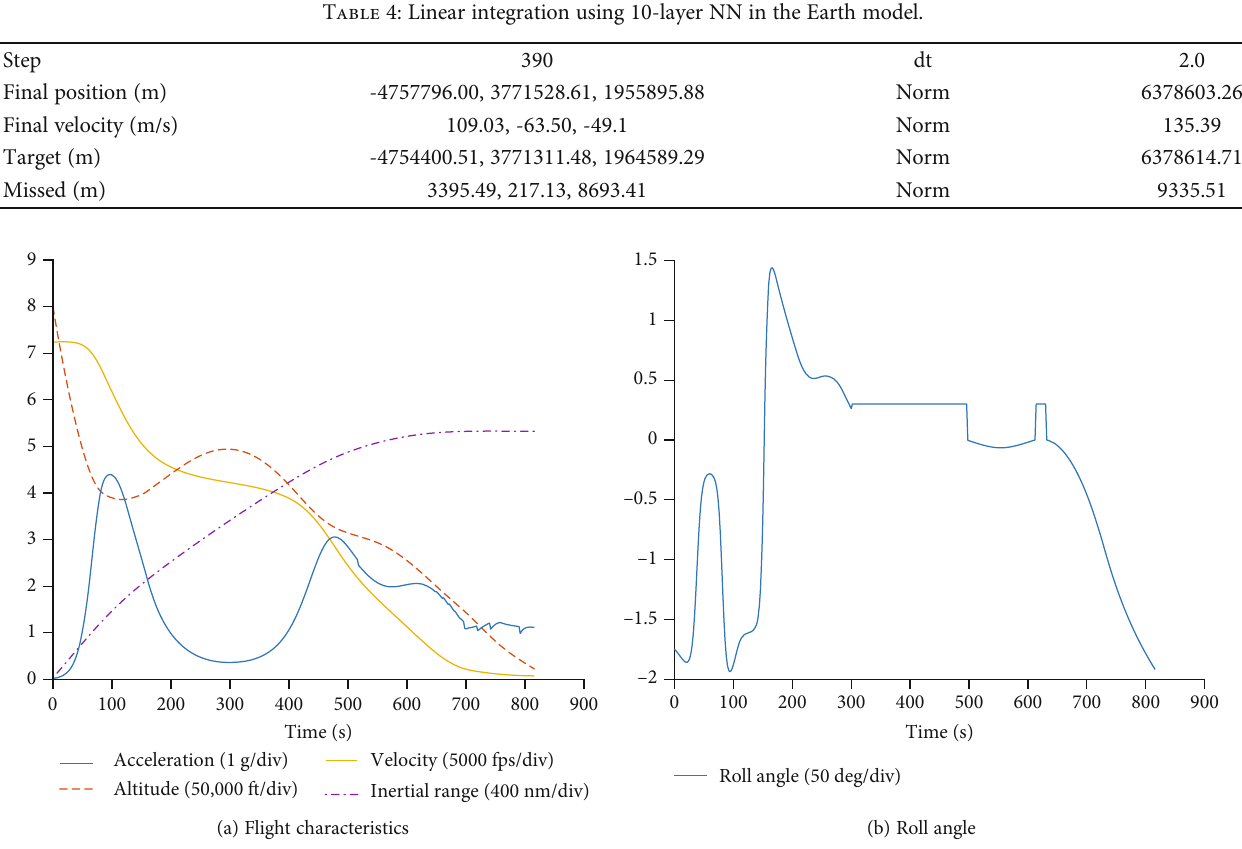
Figure 4: Neural network controller in Earth model